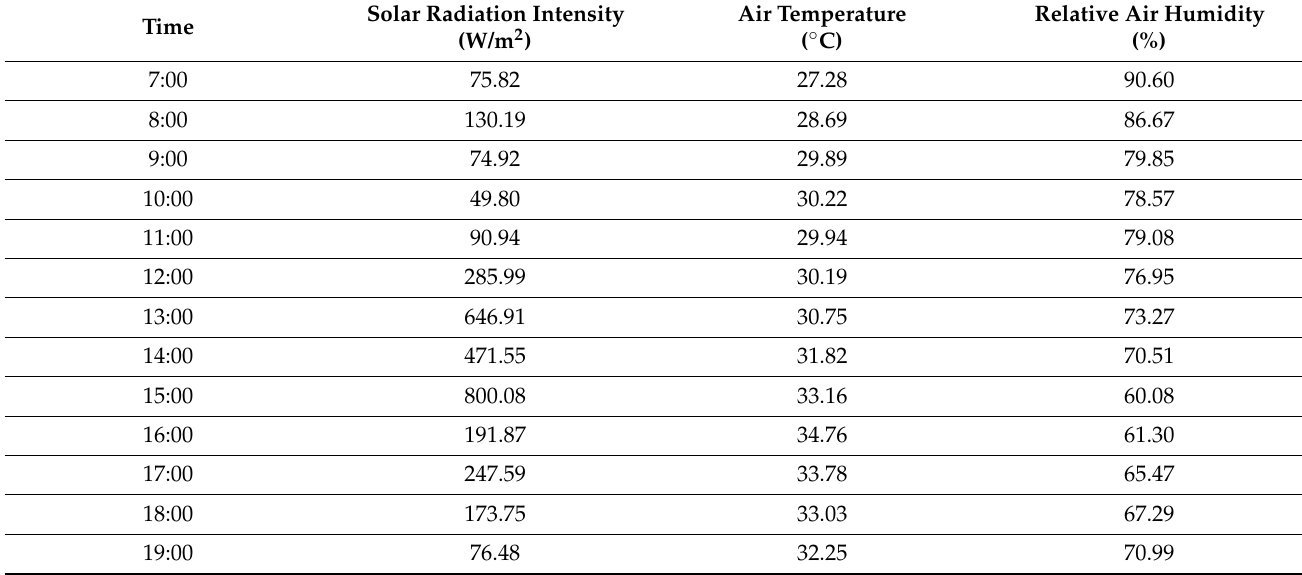
Figure 3. Small HOBO weather station. Table 1. Hourly meteorological parameters.